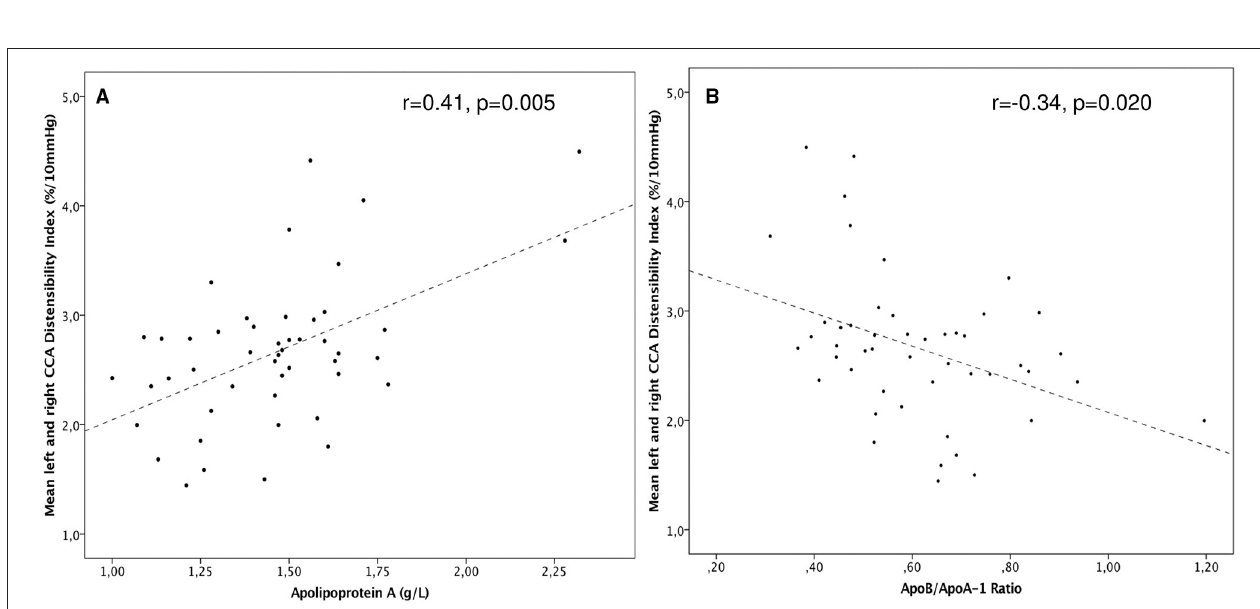
FIGURE 2 | (A) Scatterplot of common carotid distensibility (CCA DI) among CCS was positively correlated with Apo-A ( r = 0.41 , p = 0.005). (B) DI vs. the Apo-B/Apo-A1-ratio among CCS. A higher ratio depicts lower DI ( r = – 0.34 p = 0.020).